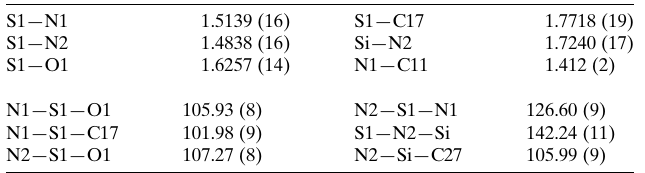
Table 1 Selected geometric parameters (A˚ , (cid:2) ).